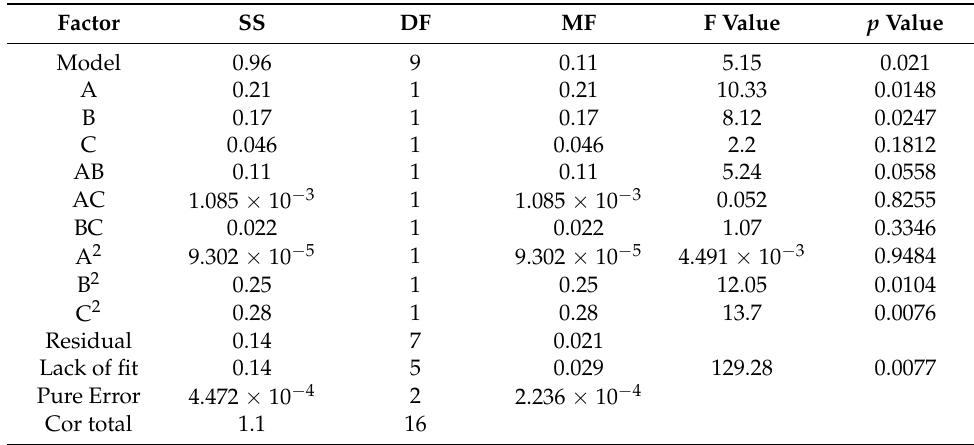
Table 5. The variance analysis of response surface quadratic regression equation.